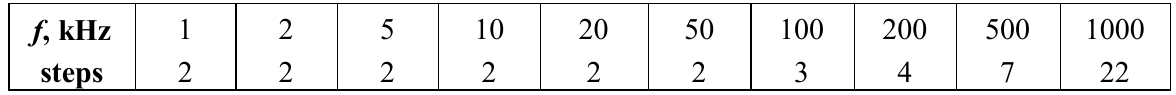
Table 3. Number of iterating steps for impedance measurement with relative error 0.05%